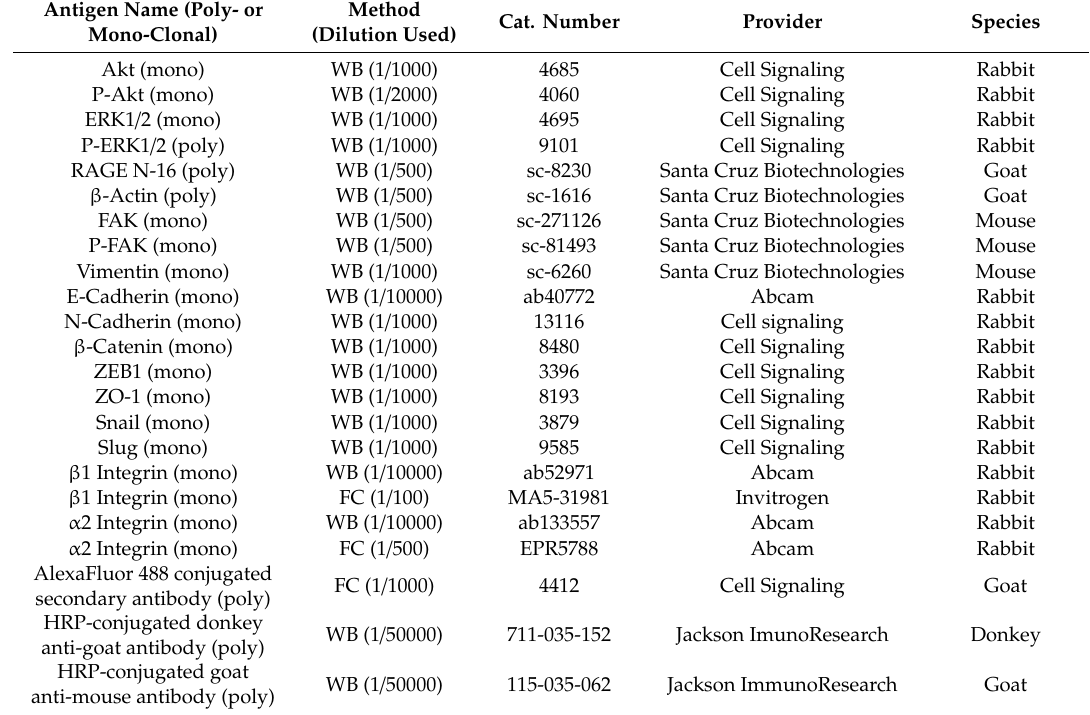
Table 2. List of primary antibodies and secondary antibodies used by Western blot (WB) and flow cytometry